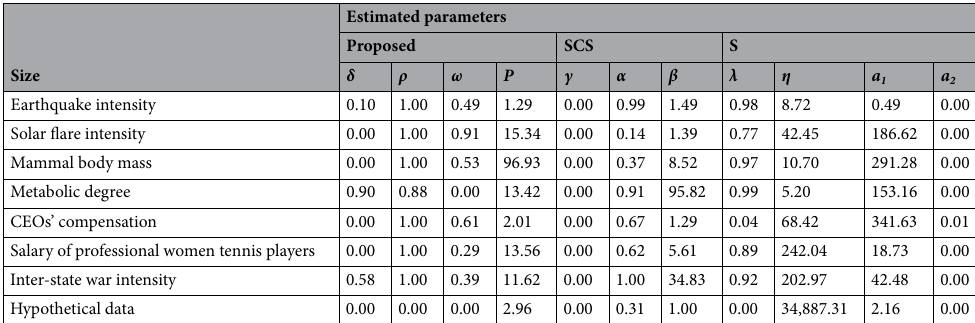
Table 3. The estimated parameters based on the proposed model, the SCS model, and the S model.